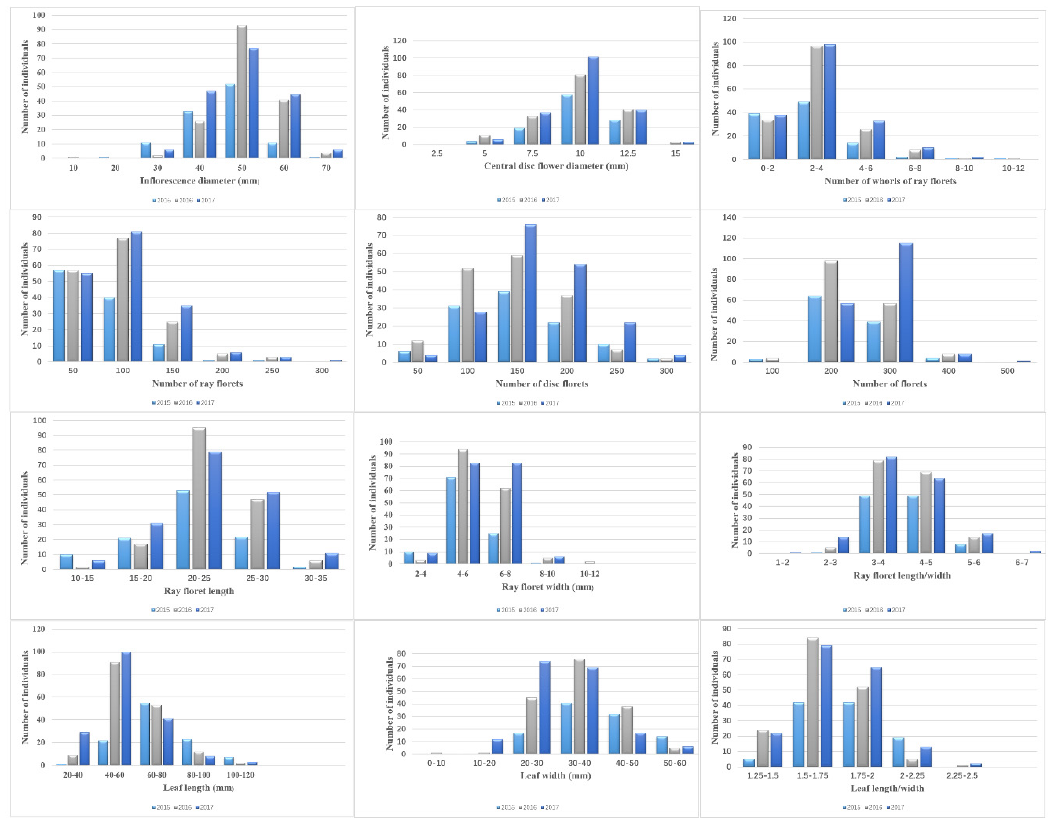
Figure 2. Frequency distributions of 12 inflorescence and leaf traits for the F 1 progeny in 2015, 2016 and 2017.